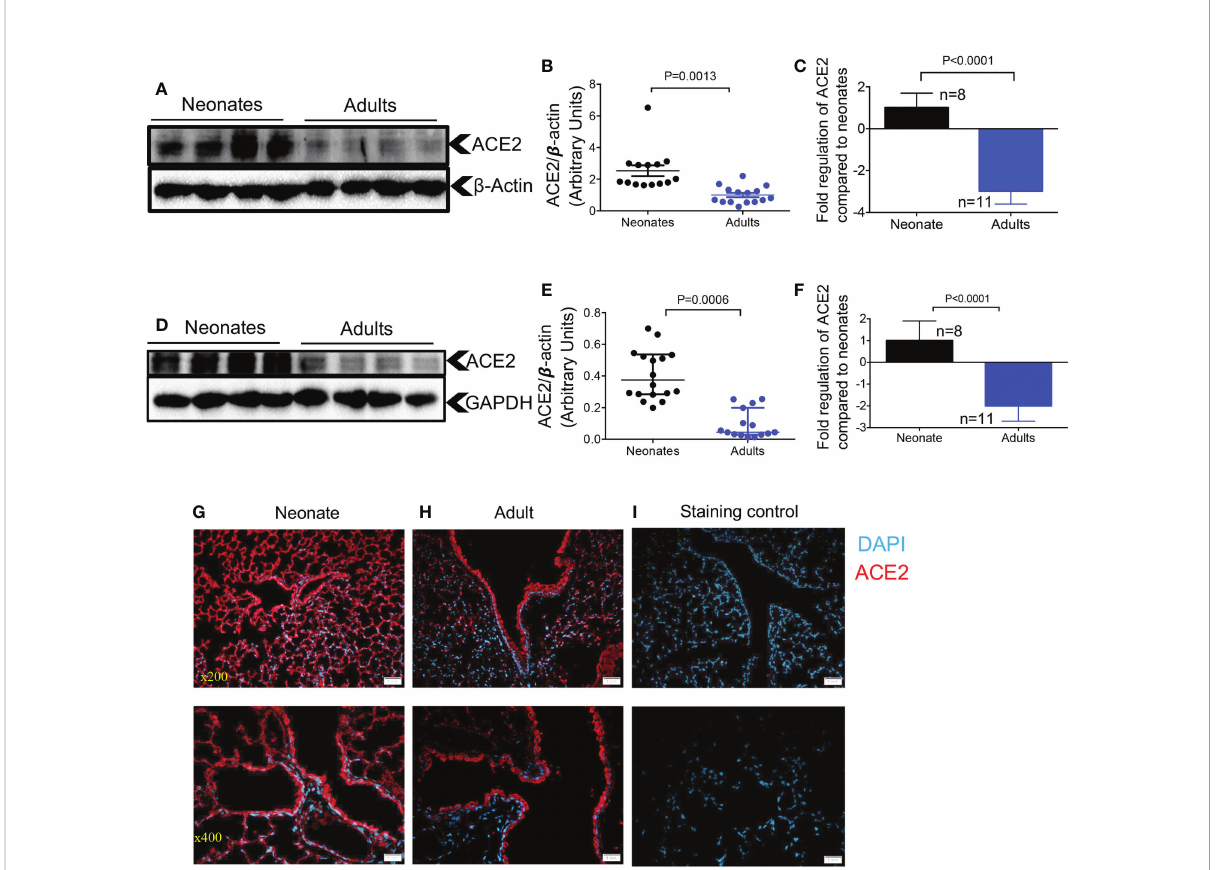
FIGURE 1 Differential expression of ACE2 and TMPRSS2 in the lung and heart tissues of neonatal compared to adult mice. (A) Representative western immunoblots, and (B) cumulative data of ACE2 protein in the lung tissues of neonatal (1-week-old) versus adult mice (> 6 months). (C) Cumulative data showing fold regulation of ACE2 mRNA in the lung tissues of neonatal versus adult mice (> 6 months). (D) Representative western immunoblots, and (E) cumulative data of ACE2 in the heart tissues of neonatal versus adult mice (> 6 months). (F) Cumulative data showing fold regulation of ACE2 mRNA in the heart tissues of neonatal versus adult mice (> 6 months). (G) Representative immuno fl uorescence (IF) images of ACE2 expression in the lung tissue of a neonatal mouse, and (H) an adult mouse (5 sections/tissue, n= >3/group). (I) IF image of the lung section stained with the secondary antibody as control. Scale bar: 100 m m. Magni fi cation x200 and x400. Sample size (n) is shown for each group. All blots were repeated for reproducibility and lanes were loaded with equal amounts of protein. Quanti fi cation of ACE2 (97 KDa) and TMPRSS2 (54 KDa) normalised to the loading control. Error bars indicate mean ± SEM from more than two independent experiments. Each dot represents data from an